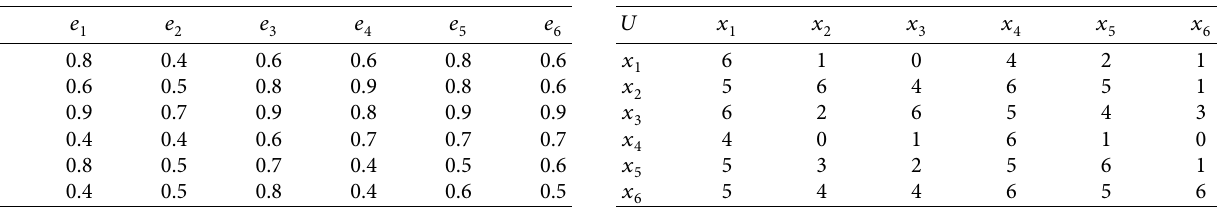
Table 5: Comparison table of ( H